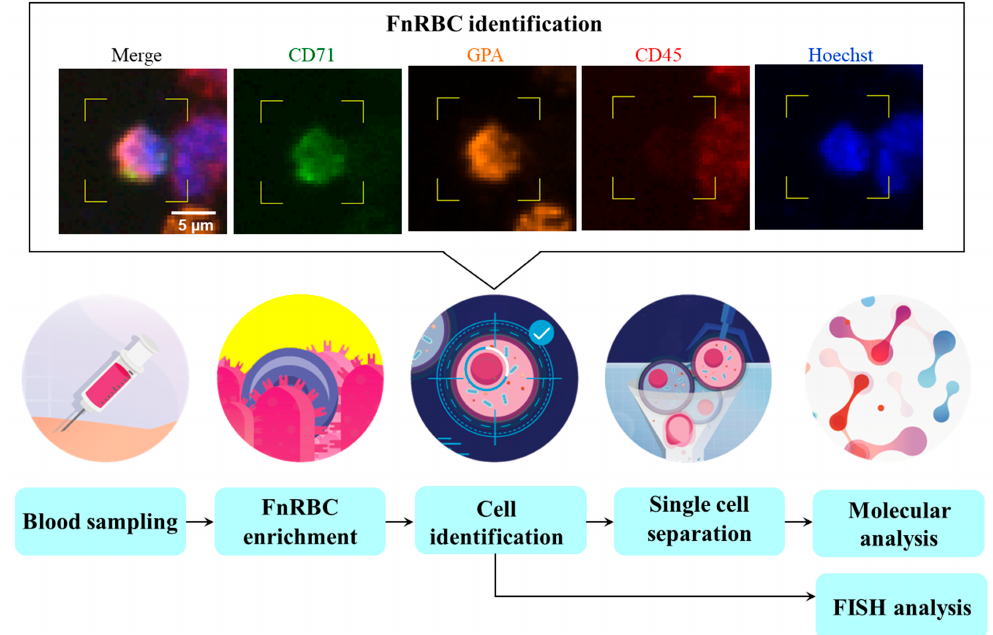
An fnRBC identified by immunocytochemistry is indicated by an arrow. Micromachines 2019 , 10 , x FOR PEER REVIEW